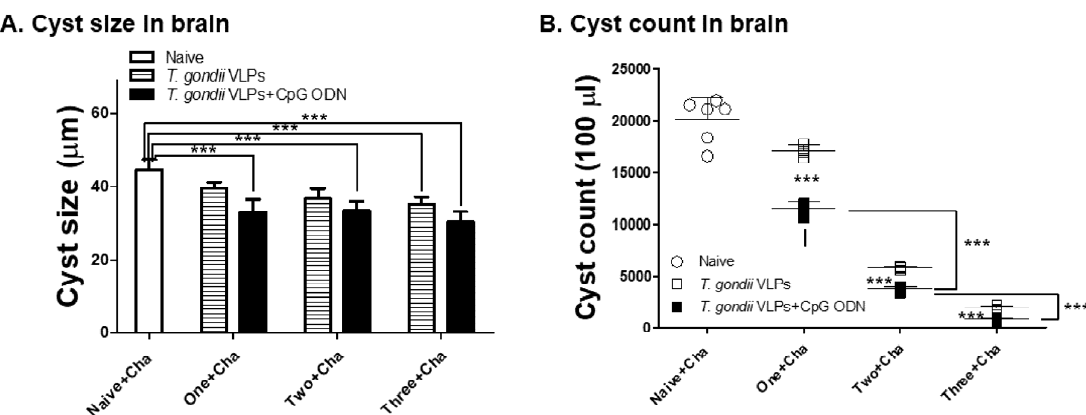
Figure 7. CpG-ODN-adjuvanted T. gondii VLP immunization reduced T. gondii cyst sizes and counts. Immunized mice ( n = 6 per group) were challenge-infected 4 weeks after the last immunization and sacrificed 35 dpi. The cyst sizes ( A ) and counts ( B ) of T. gondii in the brains were measured. Results are presented as mean ± SD and statistical significances were denoted using asterisks (*** p < 0.001). 3.7. Protective Efficacy Induced by T. gondii VLPs with or without Adjuvant CpG-ODN